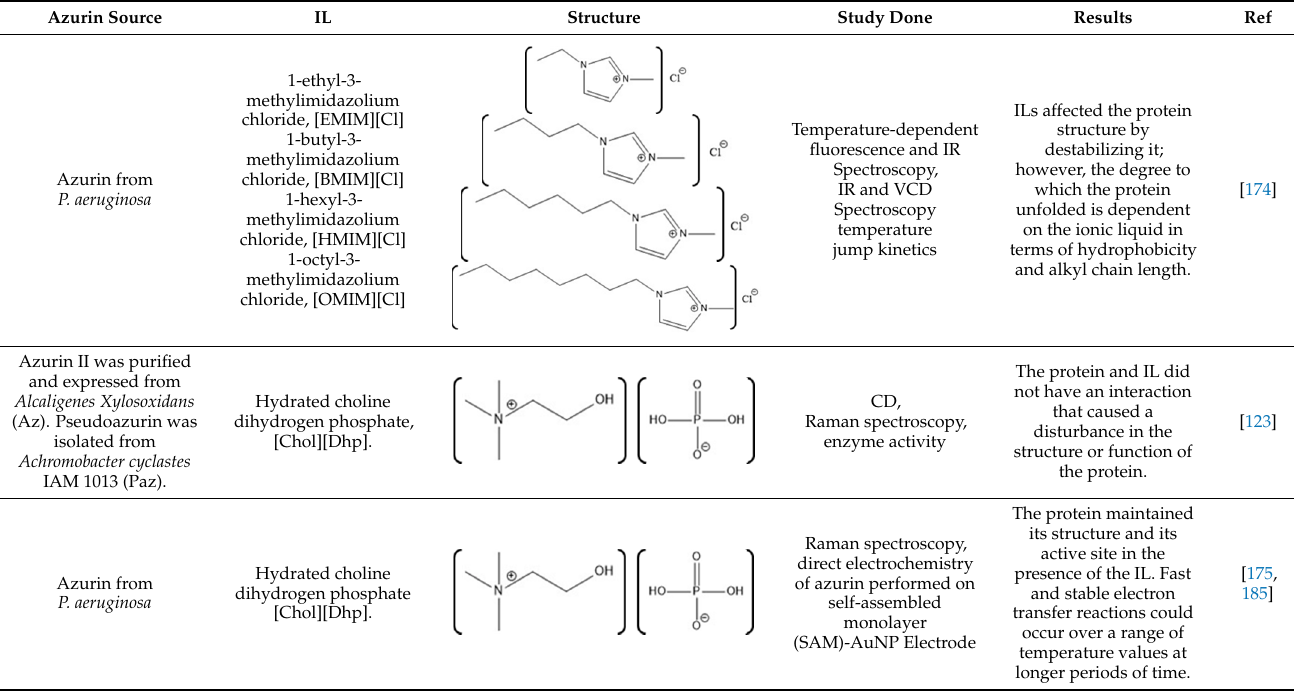
Table 4. Summary of studies done pertaining to monitoring the effects of ILs on azurin.